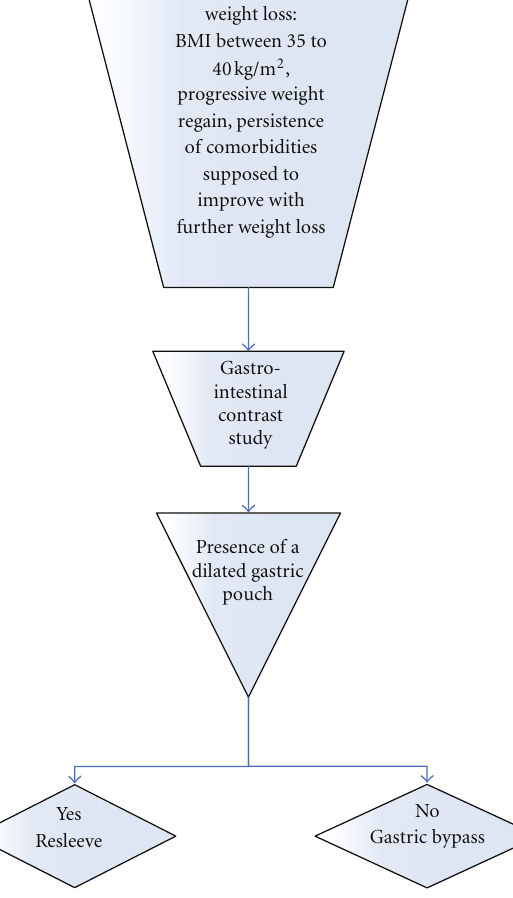
Figure 1: Decisional algorithm for the choice of revisional operation in the case of insu ffi cient weight loss.